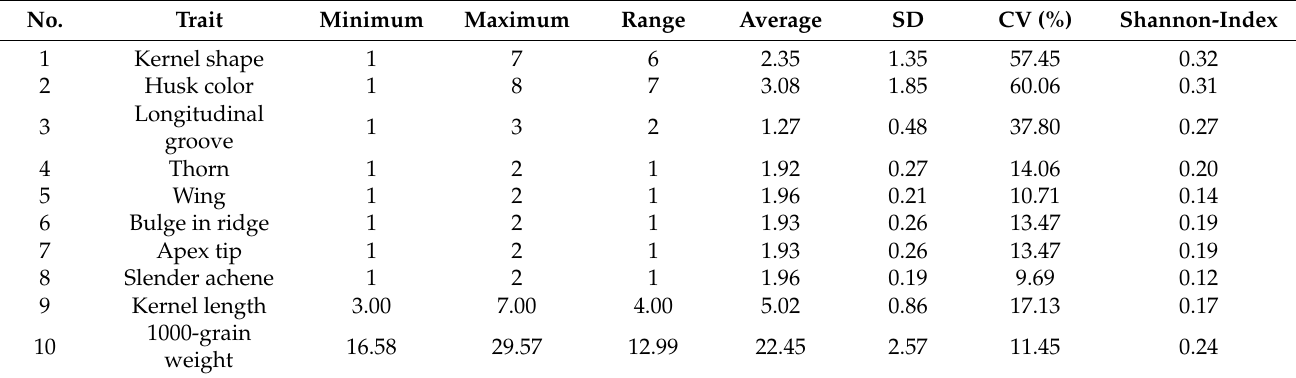
Table 2. Variations in 10 morphological traits of Tartary buckwheat landrace